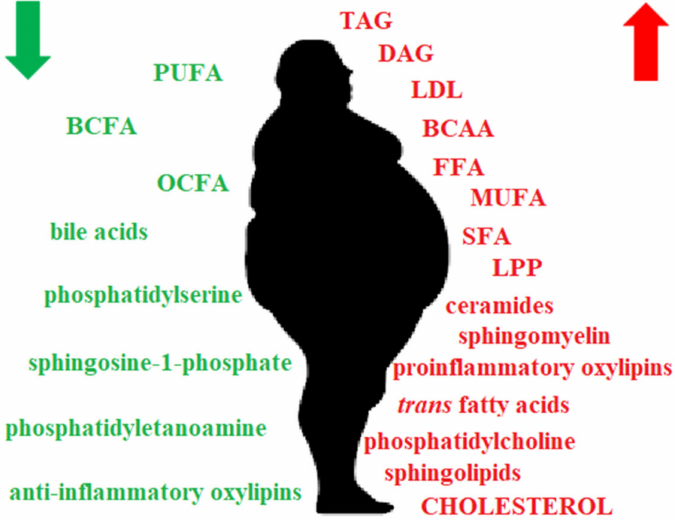
Figure 1. Lipid alterations in obesity. Lipids in red are elevated in obesity, and lipids in green are